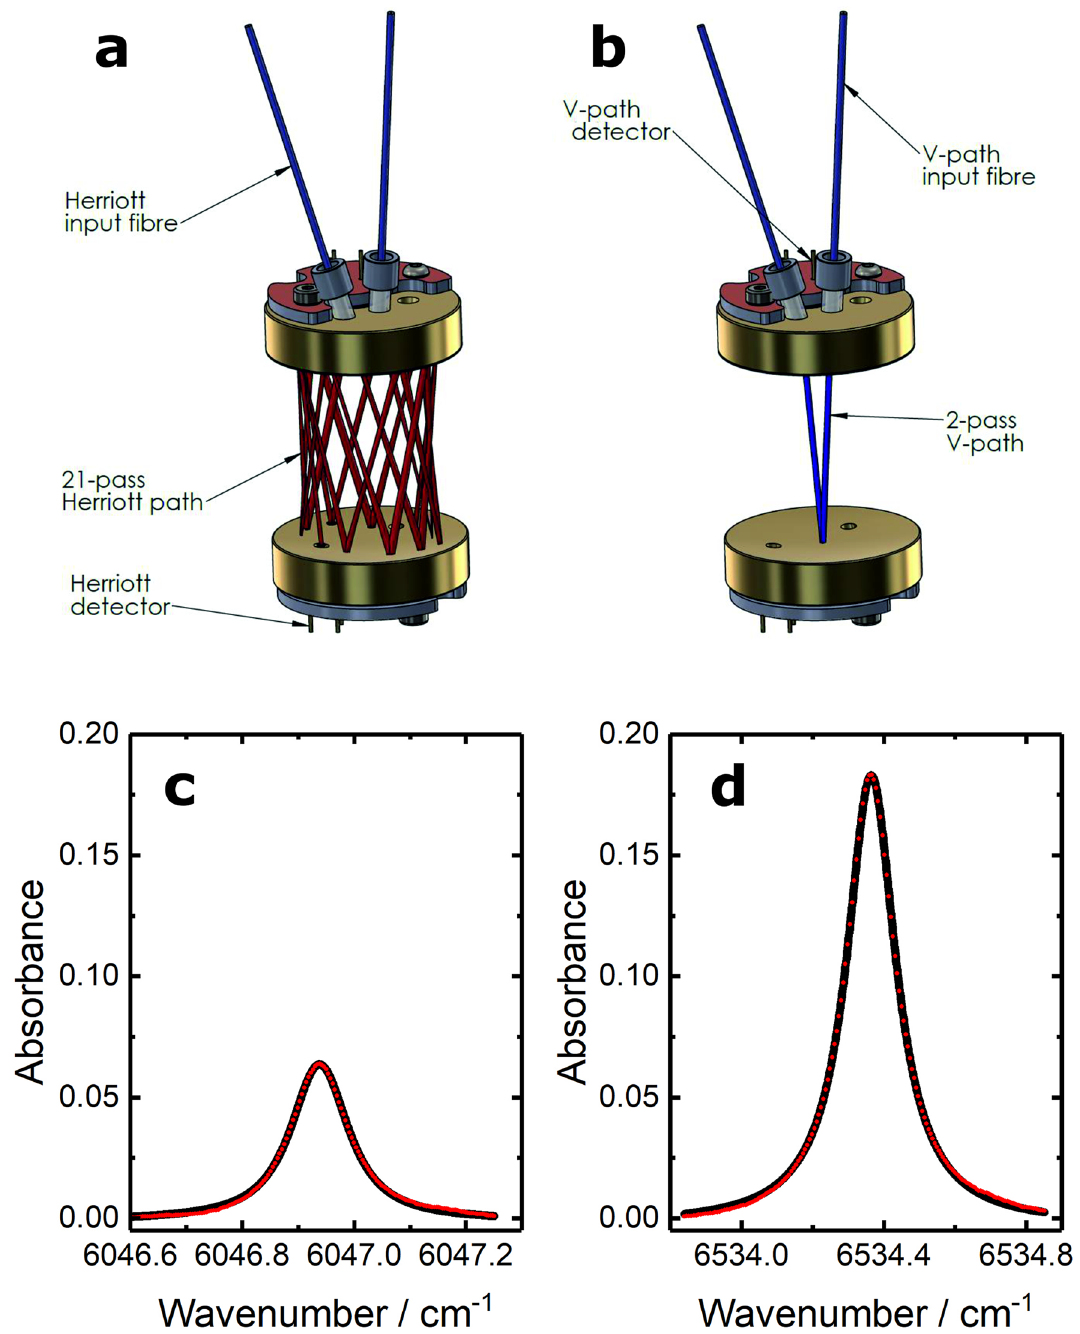
Figure 1. Implementation of multipass Herriott cell within the molecular flow sensor. ( a ) Schematic of the Herriott cell system. The spatially multiplexed radiation for probing CH 4 and C 2 H 2 is injected into the cell via a collimator, it follows a 21-pass optical path, and it is then detected by the photodiode labelled ‘Herriott detector.’ ( b ) Schematic illustrating the incorporation within the Herriott cell of the simple optical v-path used to probe CO 2 and H 2 O. ( c , d ) Absorbance spectra from the Herriott cell are shown for 3030 ppm methane ( c ) and 2760 ppm acetylene ( d ) in synthetic air. Measured absorption spectra were obtained over 10 ms and are shown as filled red circles. The fitted Voigt distributions are shown as black